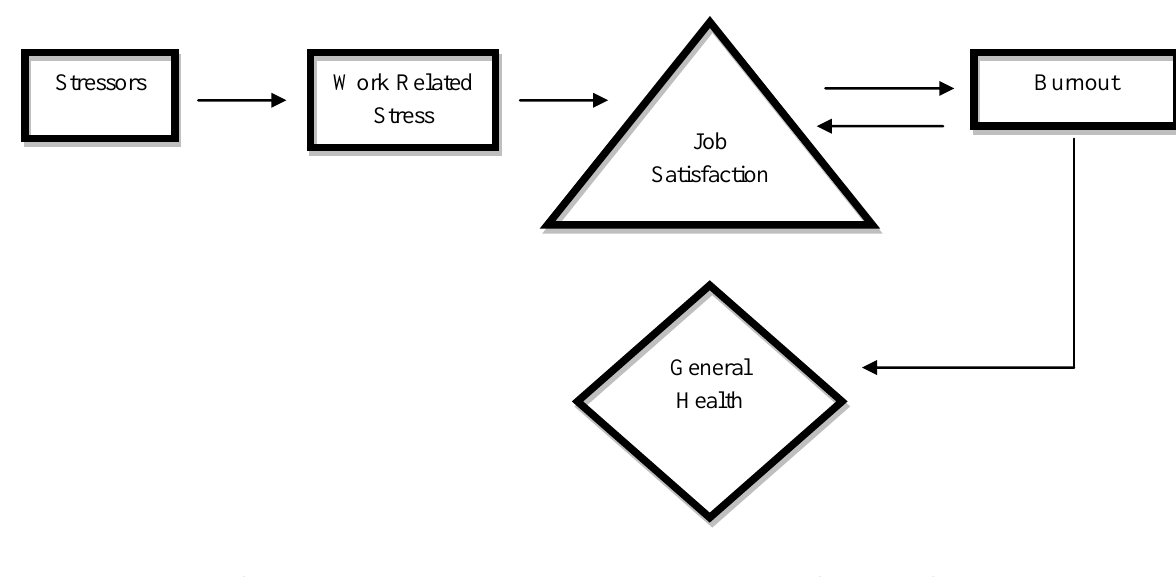
Figure 1. A model illustrating relationships between contributing factors and health outcomes of burnout among